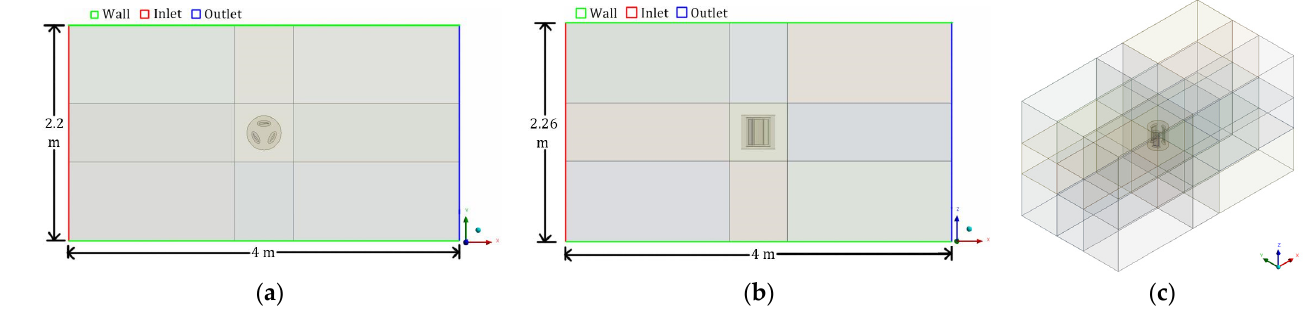
Figure 2. Darrieus vertical axis wind turbine (VAWT) geometry: ( a ) Viewed from above; ( b ) Viewed from side; ( c ) Isometric view.